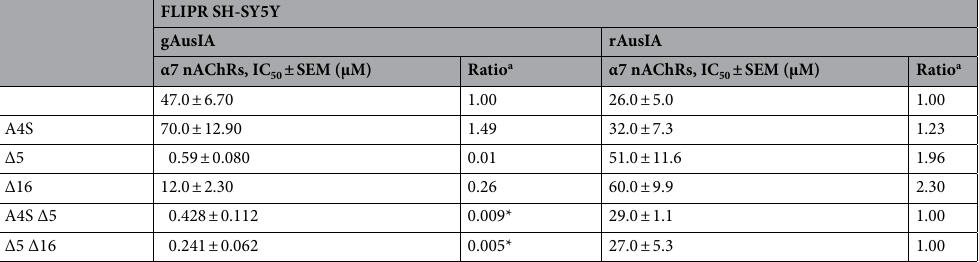
Table 3. IC 50 for the inhibition of choline activation of α7-containing nAChRs in SH-SY5Y cells by AusIA double mutant. *Denotes significant change in IC 50 compared to wildtype. a IC 50 ratio was calculated between gAusIA/rAusIA and its corresponding